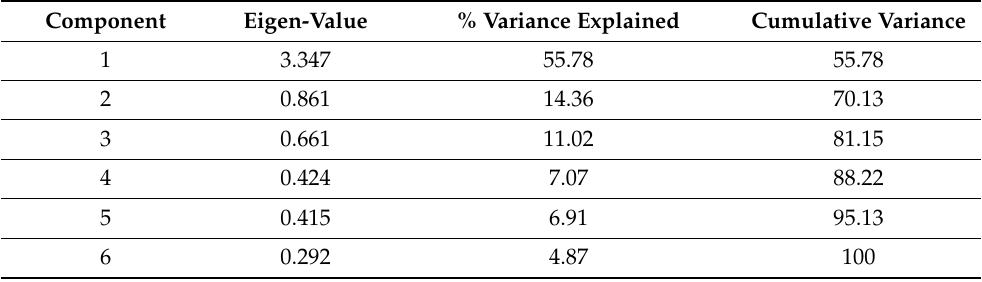
Table 2. Eigenvalues and explained variance (per factor and cumulative) of the explorative fac- tor